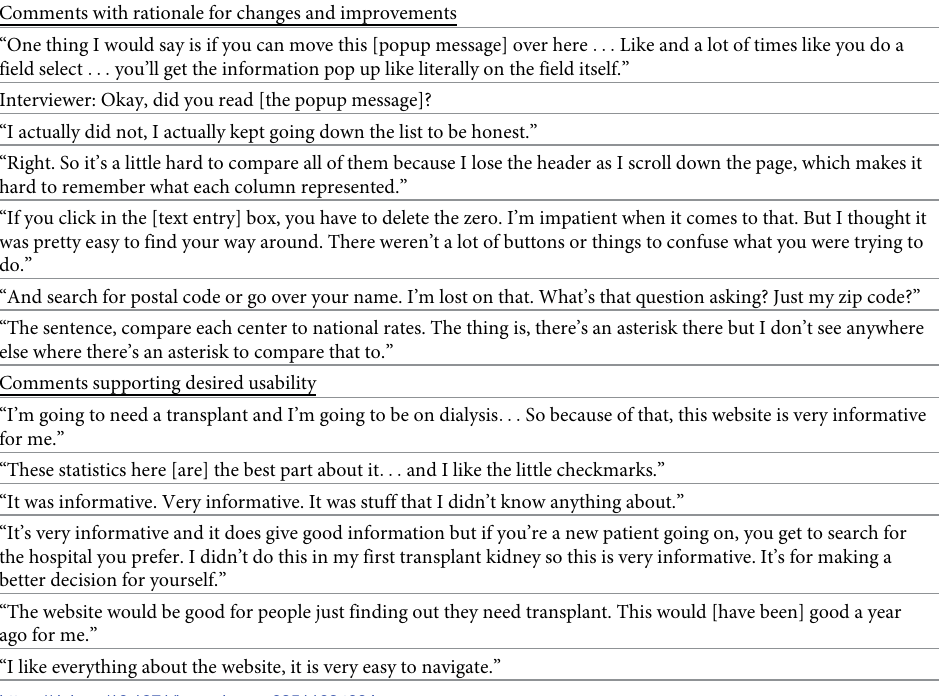
Table 4. Excerpts of kidney patient usability testing comments. Comments with rationale for changes and